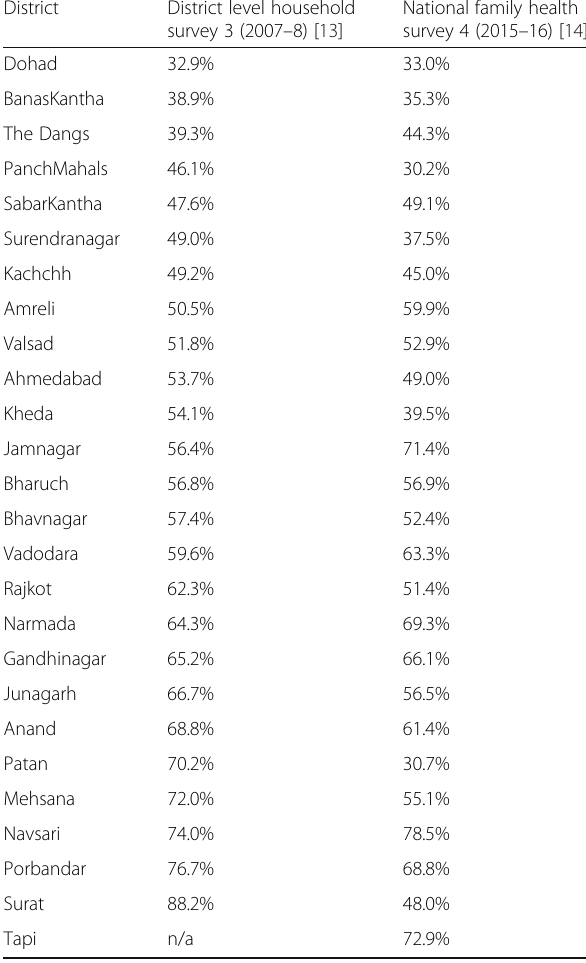
Table 1 District level immunization coverage a , Gujarat, India b